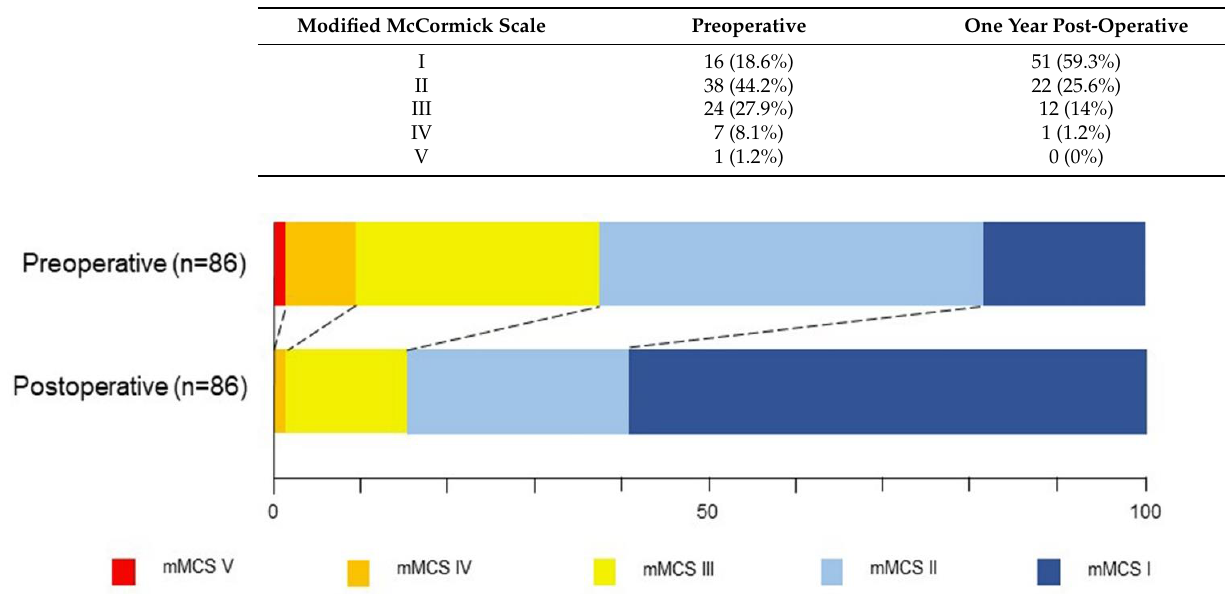
Table 2. Pre and post-operative modified McCormick Scale.